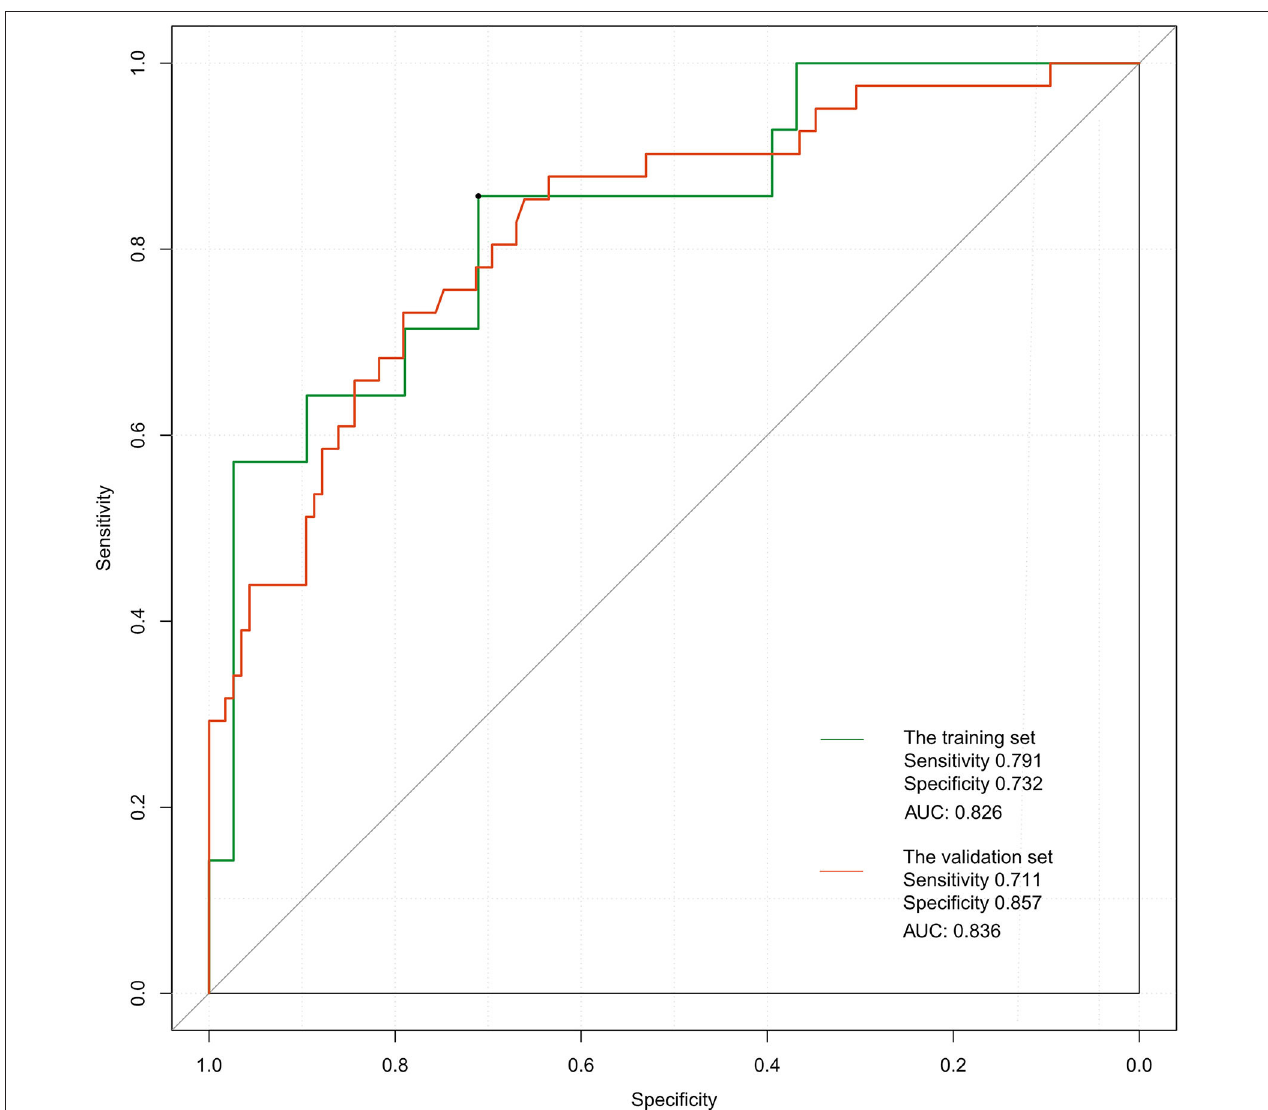
FIGURE 5 | Receiver operating characteristic curves of the proposed nomogram in the training and validation